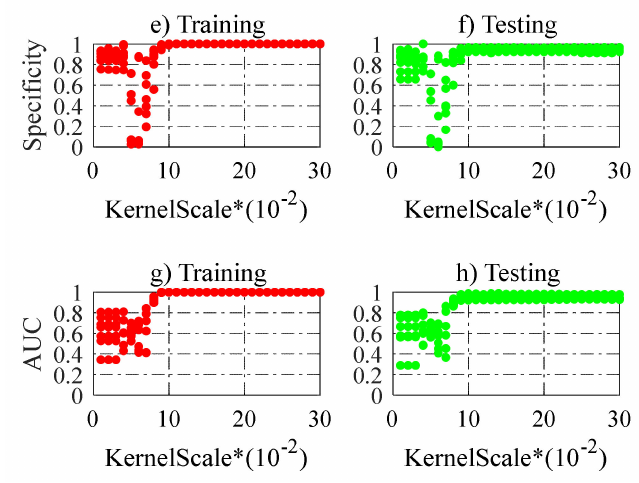
Figure 16. Performance of 210 SVM models for classifying failure modes.